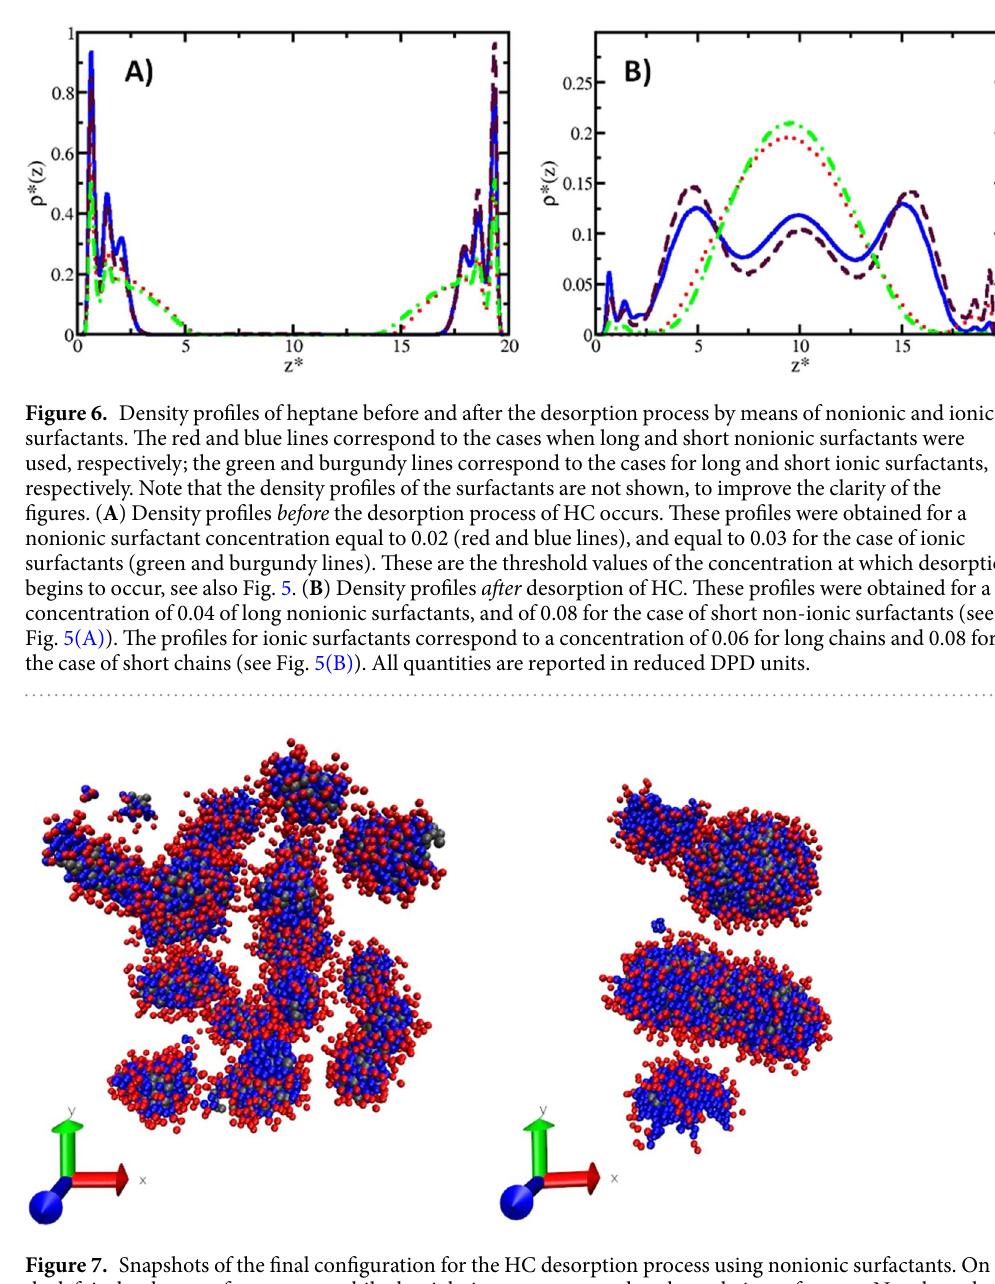
Figure 7. Snapshots of the final configuration for the HC desorption process using nonionic surfactants. On the left is the short surfactant case, while the right image corresponds to long chain surfactants. Note how the HC molecules are completely covered by the surfactant molecules. The solvent and the surfaces are omitted for